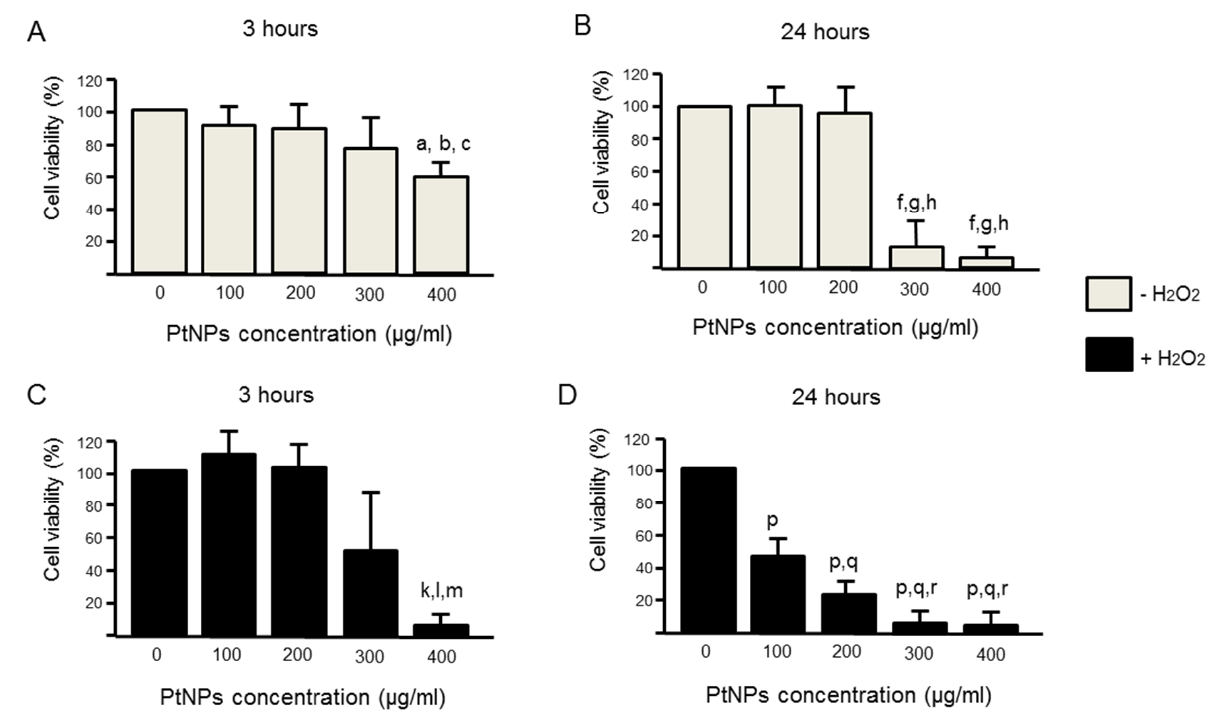
Figure 2. Cell viability in different PtNPs concentrations in two different time points (n = 3), ( A ) 3 h and ( B ) 24 h are measured by determining antioxidant capacity using FRAP assay. The 50% cell viability is determined at 400 ug/mL for 3 h and in 24 h, 300 and 400 ug/mL have shown minimal cell viability as compared to other dosages. Subsequently, several concentrations of PtNPs were introduced after cells were pretreated with H 2 O 2 in two different durations, ( C ) 3 h and ( D ) 24 h. A statistically significant difference ( p < 0.05) denoted in alphabet a–c ( A ), f–h ( B ), k–m ( C ), and p–r ( D ) that represents a comparison between a group to, a/f/k/p: untreated H 2 O 2 (0 µg/mL), b/g/l/q: 100 µg/mL, c/h/m/r: 200 µg/mL.